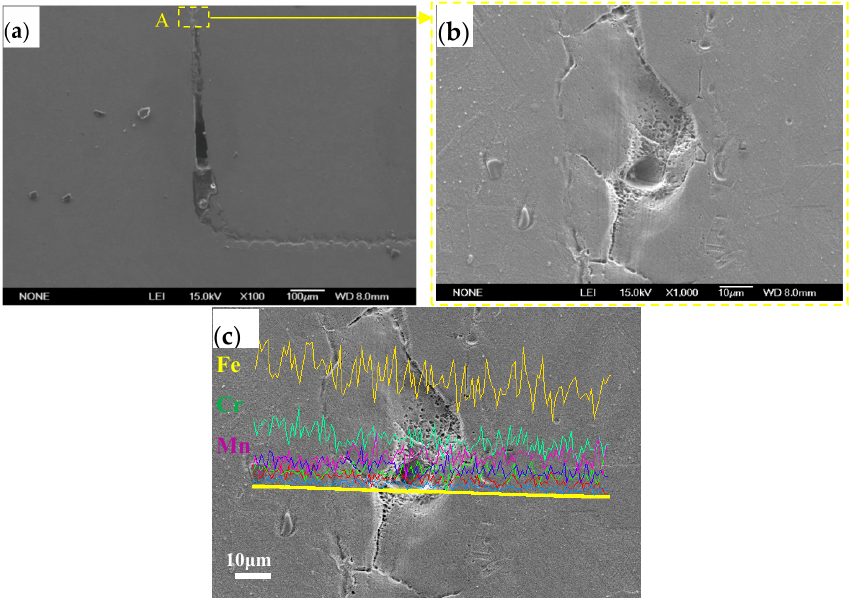
Figure 4. Microstructure of vacuum brazing joint of 1Cr18Ni9Ti with Mn-based filler metal: ( a ) the center of brazed joint, ( b ) magnified morphology of zone “A” and ( c ) line scanning analysis.